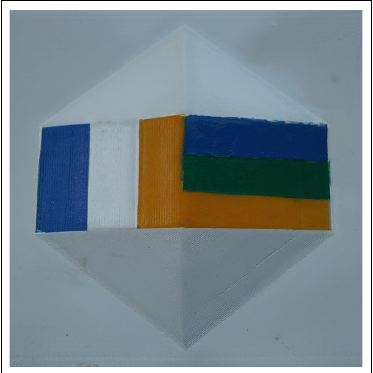
Figure 12. 3D-printed color object is generated using 3D printer and painted with different colors.